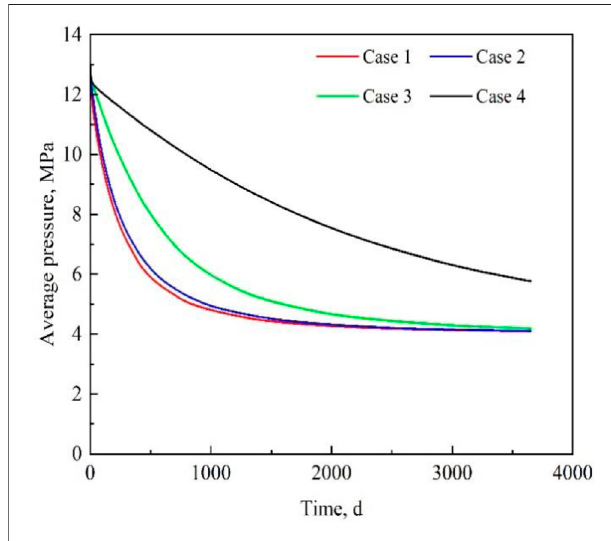
FIGURE 7 | Changes of average